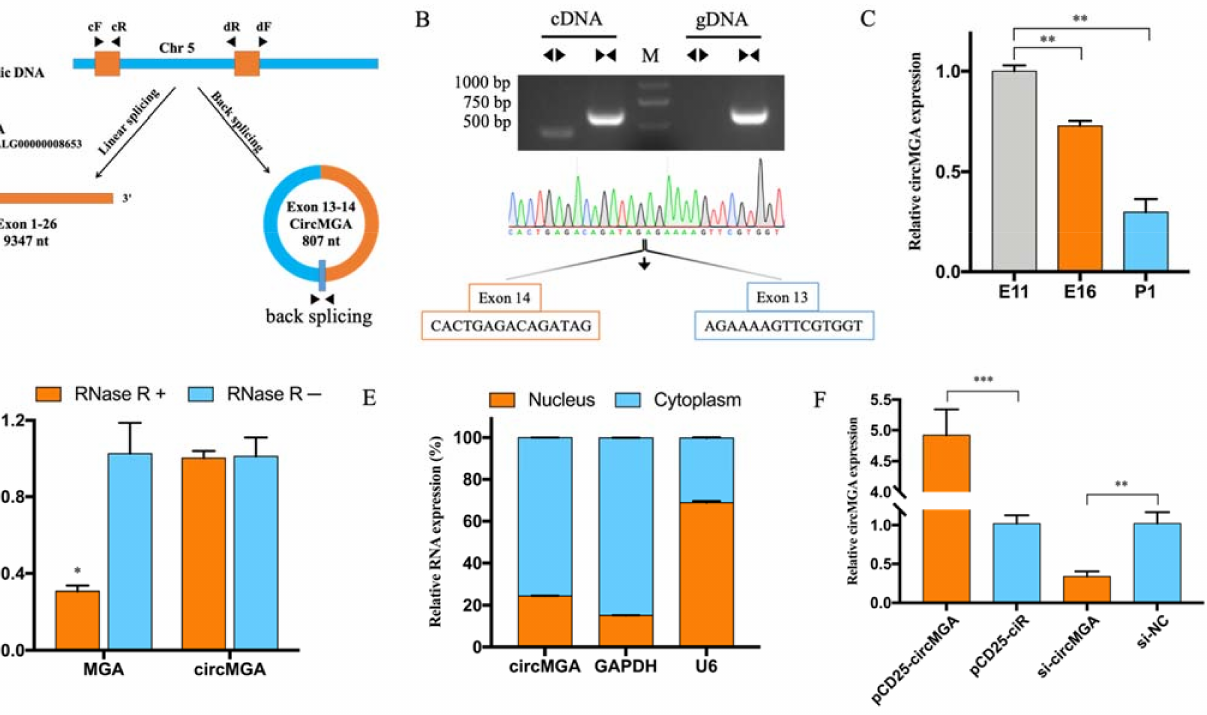
Figure 1. The characteristic of circMGA. ( A ) The schema of circMGA is derived from the exon 13-14 of the MGA gene. ( B ) Divergent primer amplified circMGA in cDNA but not gDNA, Sanger sequencing confirmed the junction sequence of circMGA. ( C ) The expression pattern of circMGA in E11, E16, and P1. ( D ) qRT-PCR results of MGA mRNA and circMGA after RNase R digestion. ( E ) CircMGA is localized mainly in the cytoplasm of myoblast cell. GAPDH and U6 serve as cytoplasmic and nuclear localization controls respectively. ( F ) CircMGA successfully overexpressed and inhibited in myoblast after transfected with pCD25-circMGA and si-circMGA. (* p < 0.05; ** p < 0.01, *** p <